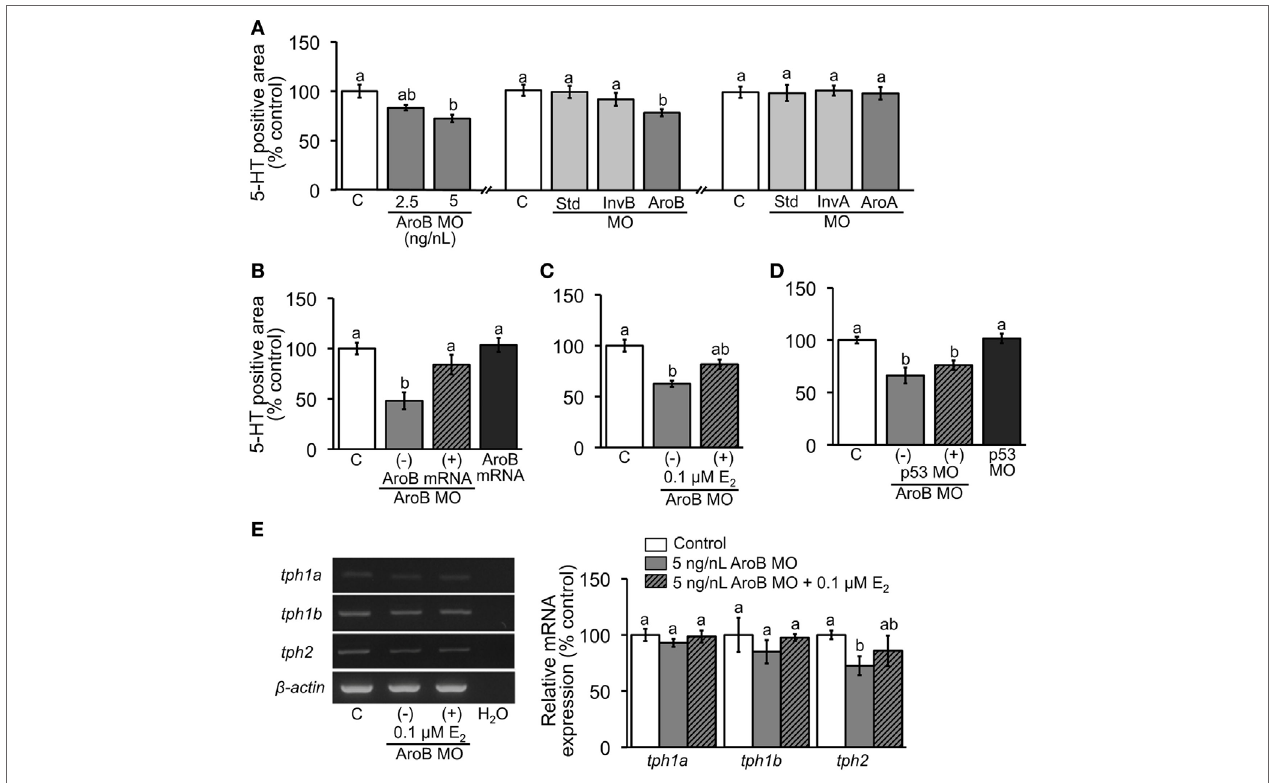
FigUre 4 | AroB MO-mediated effect on serotonergic neuron. 5-HT-positive neuron area was measured in 2-dpf embryos; (a) injection of AroB MO and control MOs (Std MO, InvB MO and AroA MO); (B,c) co-injection of AroB mRNA and exposure to E 2 , respectively, to rescue the effect of AroB MO; (D) co-injection of p53 MO to test off-target effect of AroB MO. (e) Semi-quantitative PCR measurement of expression of tph isoforms in 6-dpf larvae injected with AroB MO with and without exposure to E 2 . Data are presented as a mean ± SEM. Different letters in each graph indicate significant differences ( p <